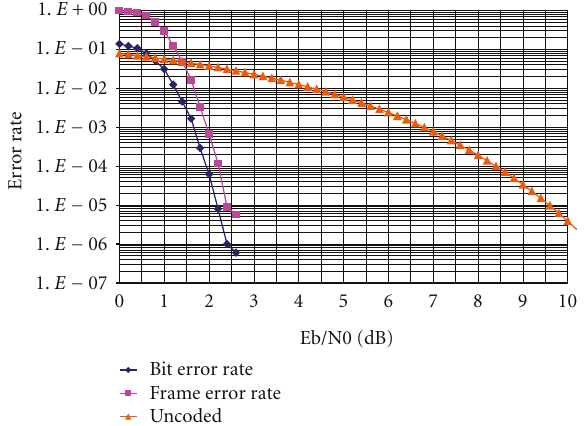
Figure 9: Error-Rate performance curves for the considered (128,64) irregular LDPC code.